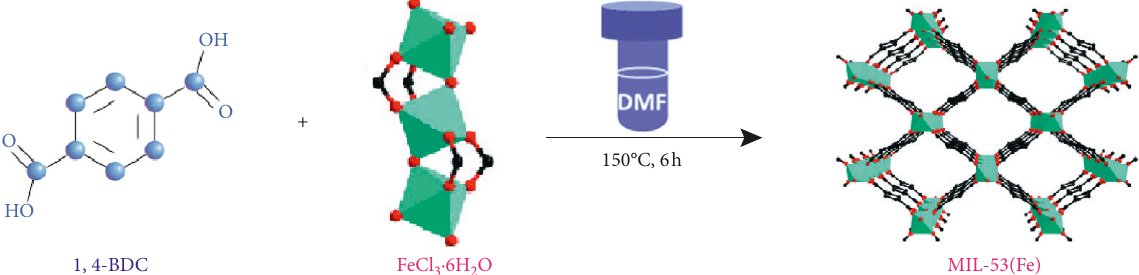
Figure 2: Schematic illustration for the synthesis of the MIL-53(Fe). The simulated structure of MIL-53(Fe) and iron(III) clusters was reproduced from [41].